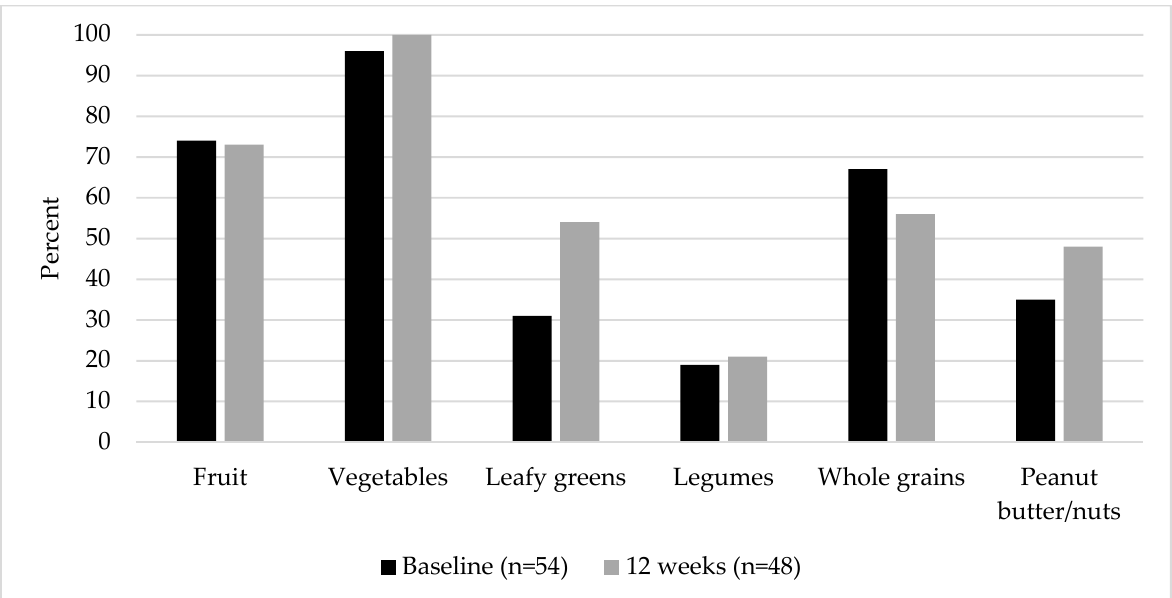
Figure 3. Percent of the participants enrolled in the Healthy Roots intervention consuming targeted food groups.